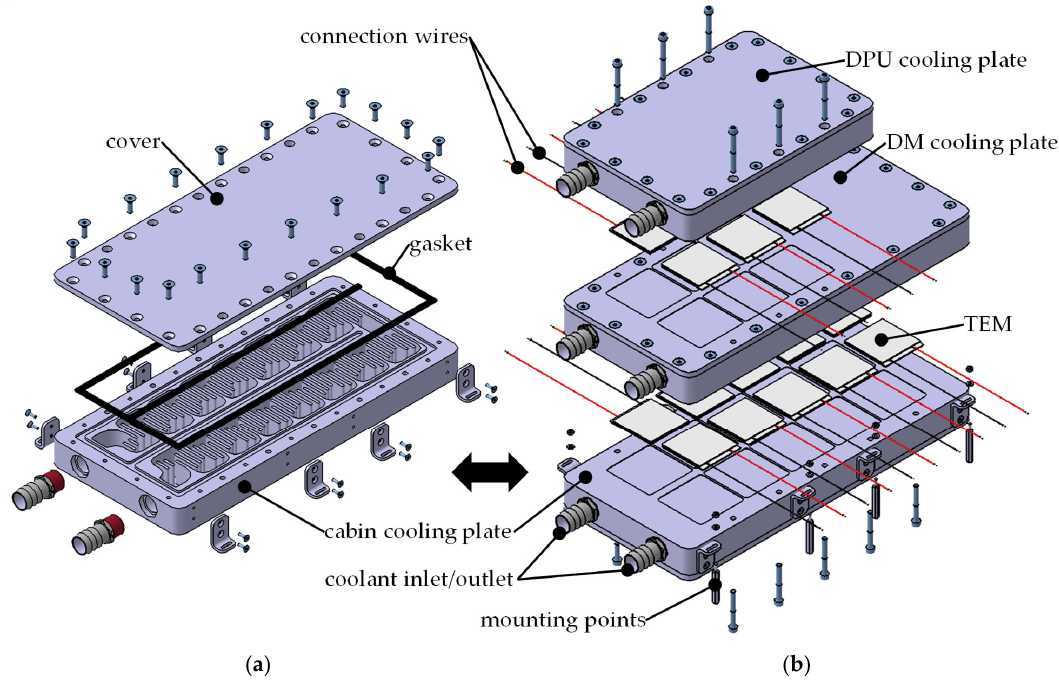
Figure 10. Exploded view of the thermoelectric heat pump: ( a ) Cabin cooling plate with final coolant channel design; ( b ) Complete assembly with all three cooling plates and TEMs.